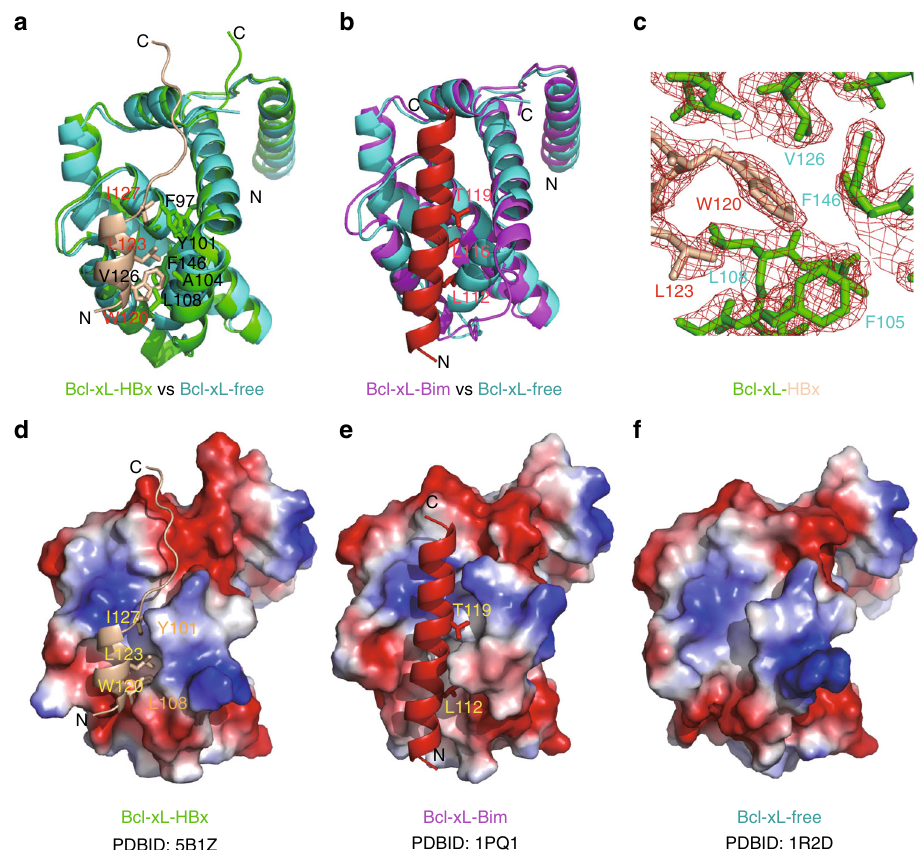
Fig. 1 The crystal structure of the Bcl-xL/HBx-aa113 – 135 complex. a Cartoon representation of structural comparison of Bcl-xL/HBx-BH3 motif with Bcl-xL at free form (PDB ID 5B1Z). The structures of Bcl-xL/HBx-BH3 motif and Bcl-xL at free form are colored in green and cyan, respectively. The bound HBx- BH3 peptide is shown in carton mode and colored in wheat. The key residues involved in tight interactions are highlighted in stick mode. b Cartoon representation of structural comparison of Bcl-xL/Bim-BH3 motif (PDB ID 1PQ1 13 ) with Bcl-xL at free form (PDB ID 1R2D 46 ). The structure of Bcl-xL/Bim- BH3 motif is colored in magenta. The bound Bim-BH3 peptide is shown in carton mode and colored in red. The corresponding key residues involved in tight interactions are highlighted in stick mode. c Electrostatic potential surface view of Bcl-xL/HBx-BH3 motif complex. The bound HBx-BH3 motif forms a short, two-helical-turn α -helix snuggling into a small hydrophobic pocket, which is partially preformed. The key residues involved in hydrophobic interactions are indicated. d Electron densities around the HBx W120 residue are shown in red mesh contours. e Electrostatic potential surface view of Bcl- xL/Bim-BH3 motif complex. The bound Bim-BH3 motif forms a continuous long α -helix fi tting into the big groove formed by Bcl-xL upon Bim binding. The corresponding key residues involved in interactions are indicated. f Electrostatic potential surface view of Bcl-xL at free form. A preformed small groove/ pocket at the bottom of the surface is observed. d – f were made by pymol using the default parameters provided. The map was calculated using Fo-Fc coef fi cients and phases from the re fi ned structure, but with the residues omitted from the Fc calculation. The map is contoured at 3 σ . The side chains of HBx-BH3 and Bcl-xL are shown in stick model. HBx and Bcl-xL molecules are colored in wheat and